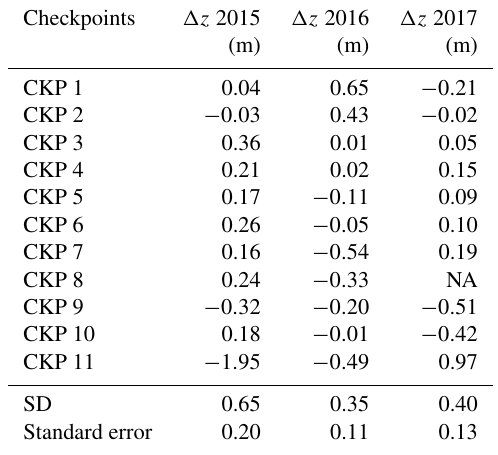
Table 4. Results of field checkpoints and the elevation